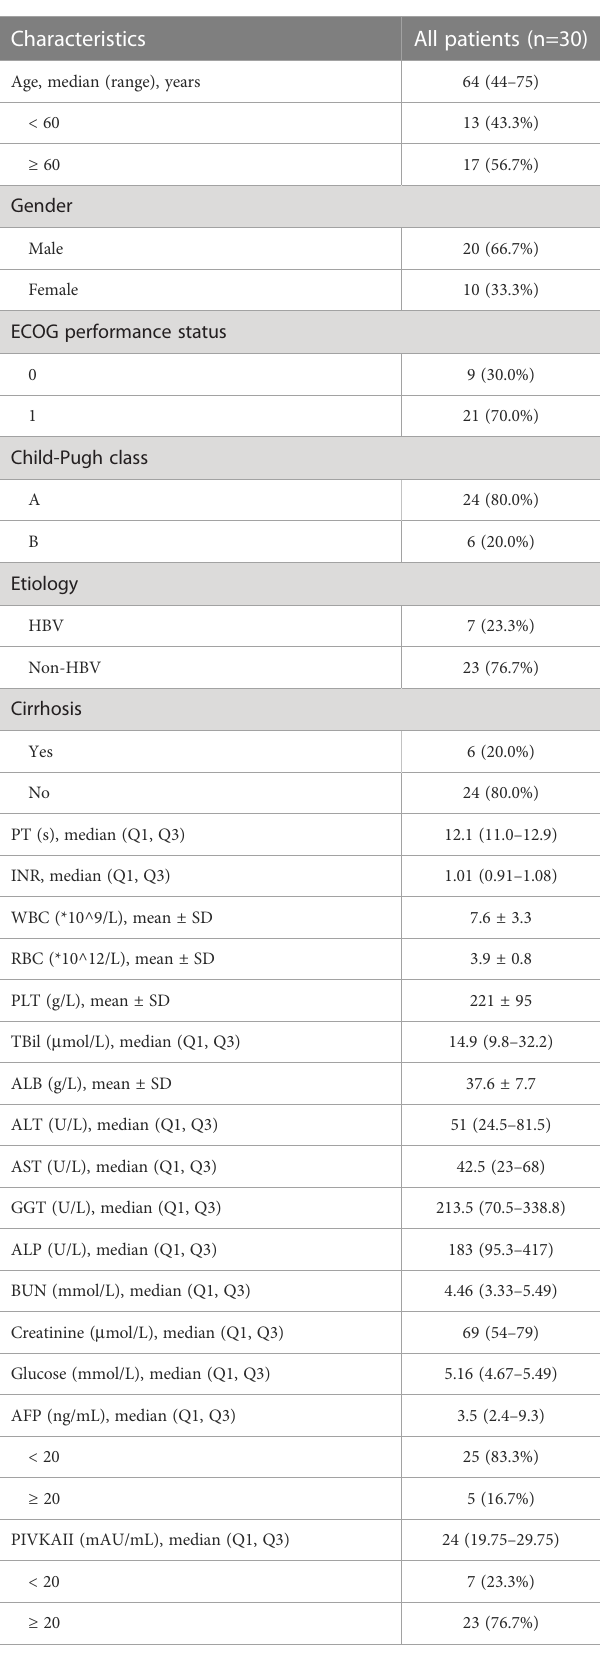
TABLE 1 Baseline demographic and clinical characteristics of advanced intrahepatic cholangiocarcinoma patients.